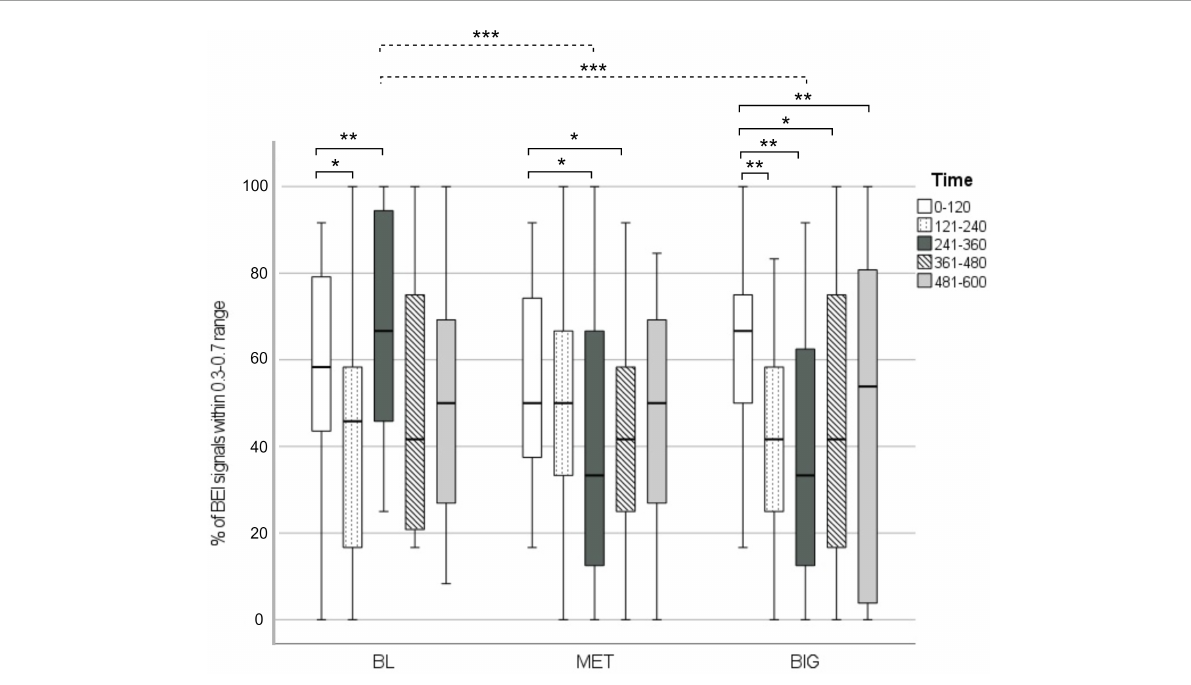
FIGURE1 % of BEI signals within the attentive range in each walking condition, across time segments. The dashed line represents significant differences between specific time segments in walking condition. The solid lines represent within-condition differences between the first time segment and each of the subsequent segments (2–5). * p < 0.05, ** p < 0.01, *** p < 0.001.